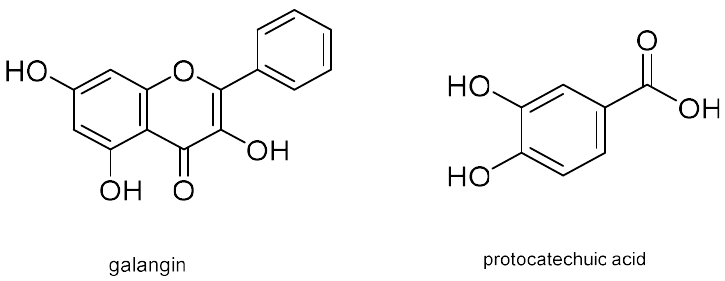
Figure 12. Metabolites present in Piper subtomentosum with potential insecticidal activity.